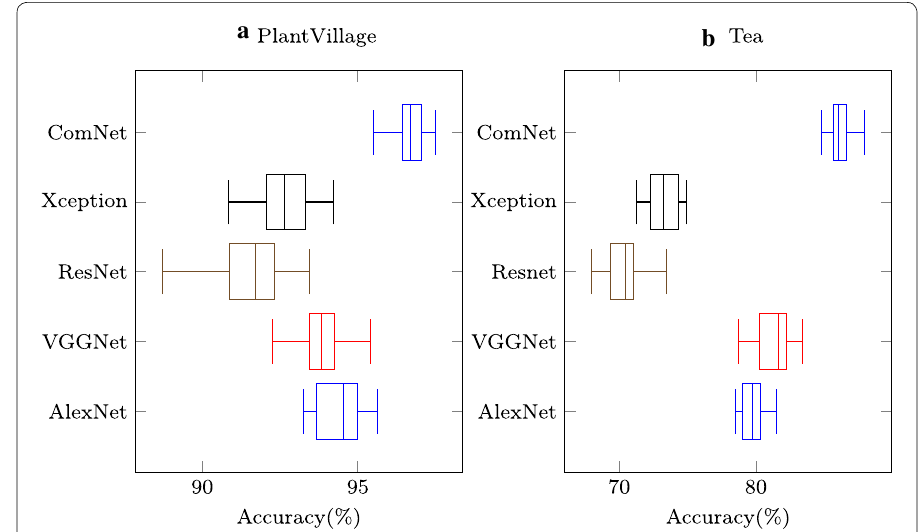
Fig. 12 Box-plot of accuracies of evaluated DCNN using 10-fold cross validations